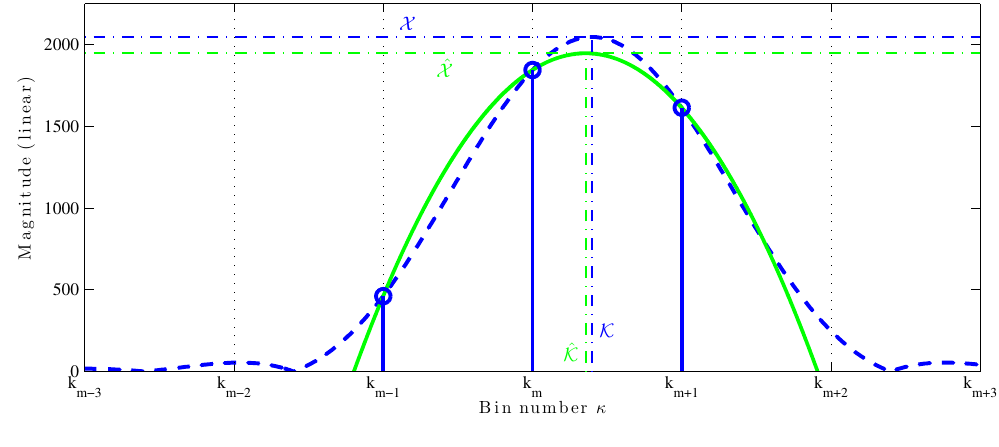
Figure 1. Demonstration of the